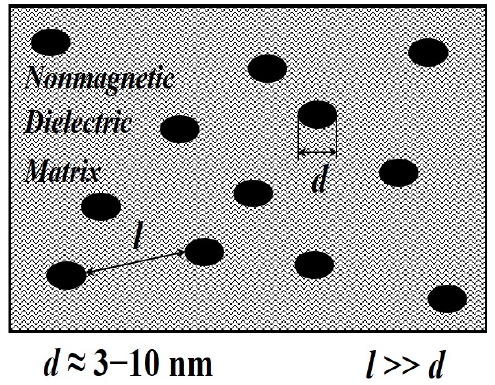
Figure 2. Scheme of nanoparticles stabilization inside a matrix stabilizer.